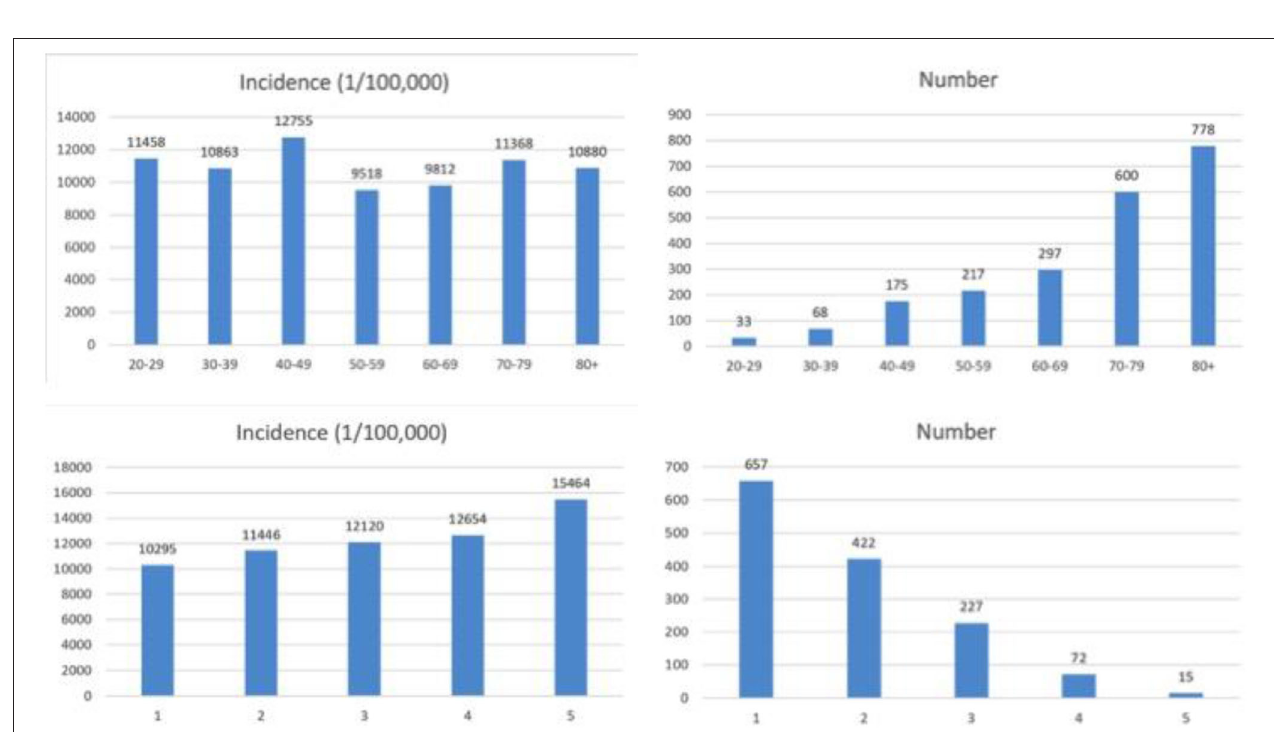
FIGURE 2 | The number of sepsis patients who developed IHCA stratified by age categories or RCRI score.